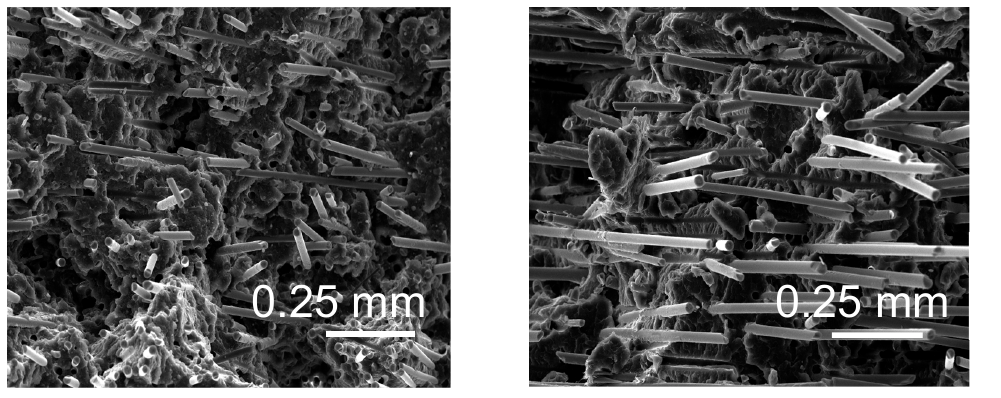
Figure 11. Effect of fiber orientation for 30 W f %, i.e., Perpendicular vs. Parallel fibers to the loading direction. In total, 30% W f is 50% recyclate and 30% perpendicular regrind sample has more fiber aligned in the loading direction and fibers aligned out of plane from the screen and 30% Parallel samples have fibers aligned in-plane to the screen.